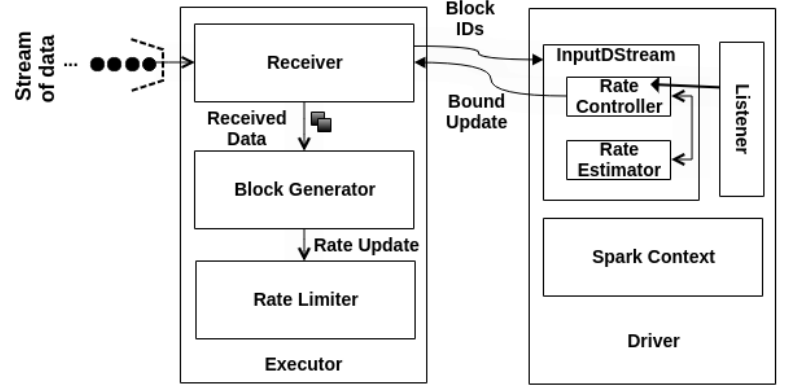
Figure 2. Spark Backpressure PID